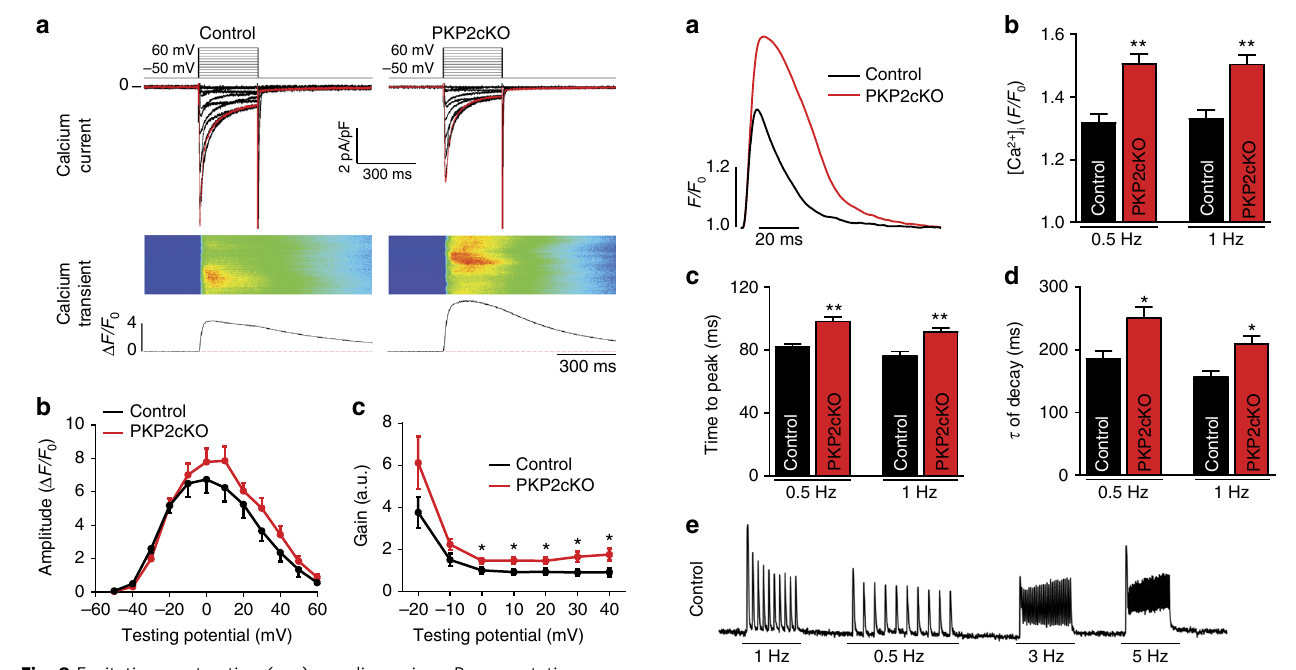
Fig. 8 Excitation – contraction (e – c) coupling gain. a Representative